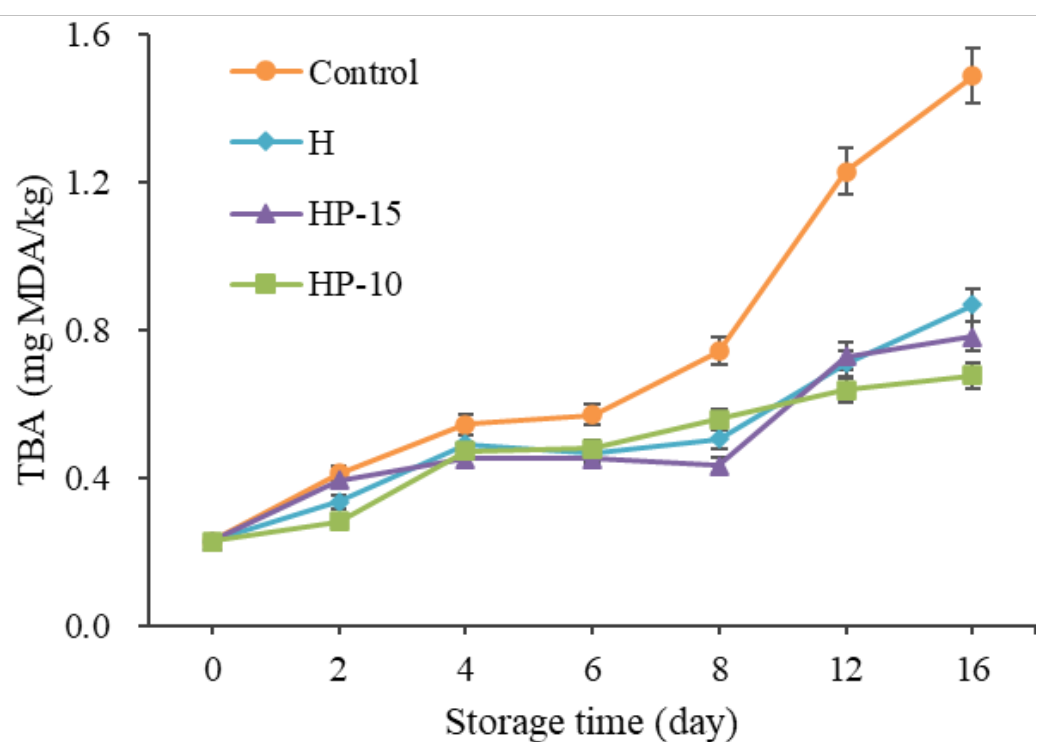
Figure 6. Changes of TBA in sturgeon fillets during refrigerated storage (CK: control; H: 2% sodium alginate + antibacterial agents; HP-10: 2% sodium alginate + antibacterial agents + 1:10 protein solu- tion; HP-15: 2% sodium alginate + antibacterial agents + 1:15 protein solution).